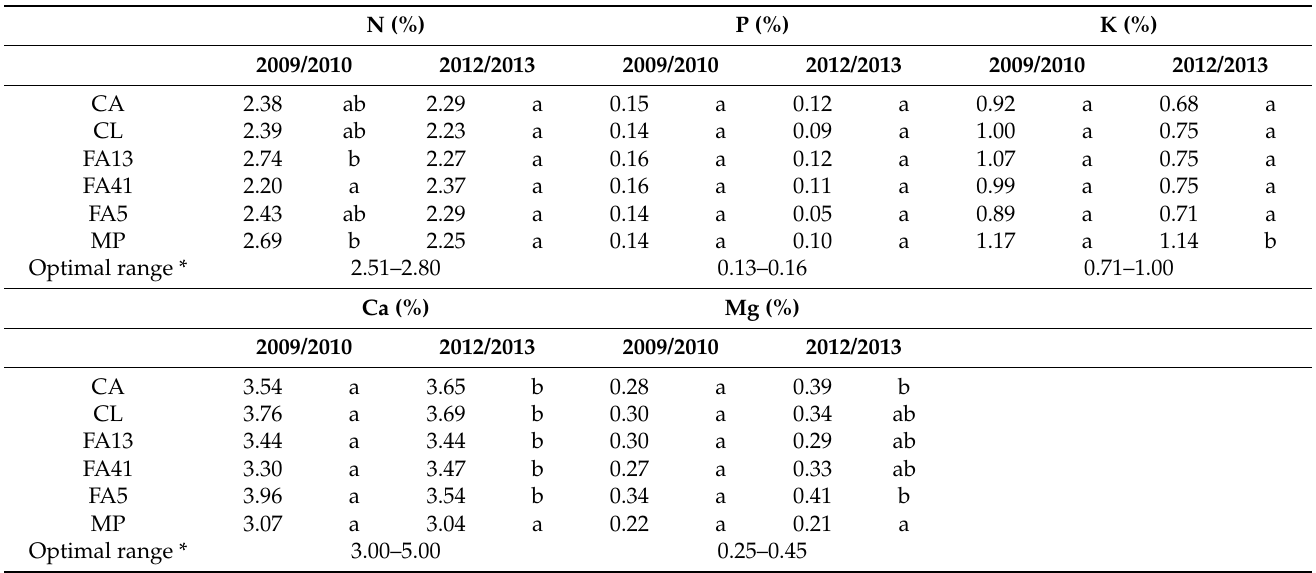
Table 5. Effect of rootstocks on ‘Lane Late’ navel orange leaf macro-nutrients (N, P, K, Ca and Mg) contents over two growing seasons, 2009/2010 and 2012/2013.